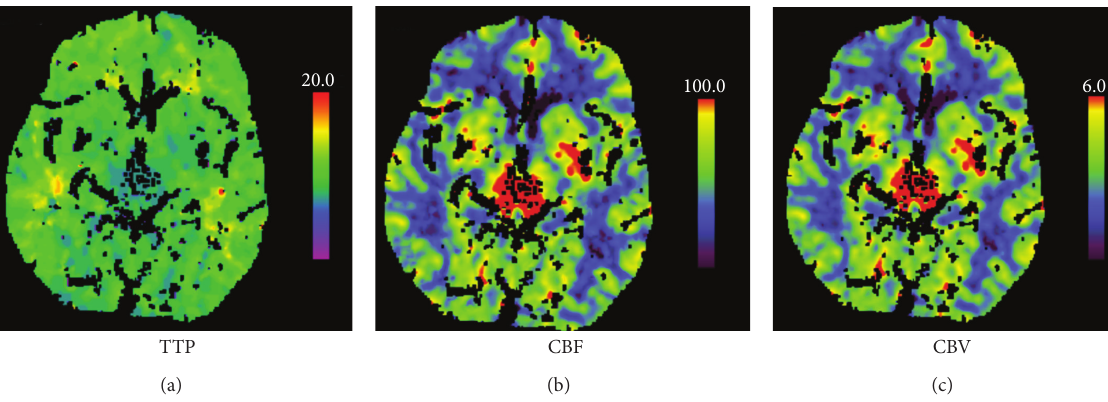
Figure 3: CT perfusion on admission. Time-to-peak map (TTP, (a)) showing reduced time-to- peak and cerebral blood flow map (CBF, (b)) and cerebral blood volume map (CBV, (c)) showing increased relative cerebral blood flow and relative cerebral blood volume in thalamus bilaterally.